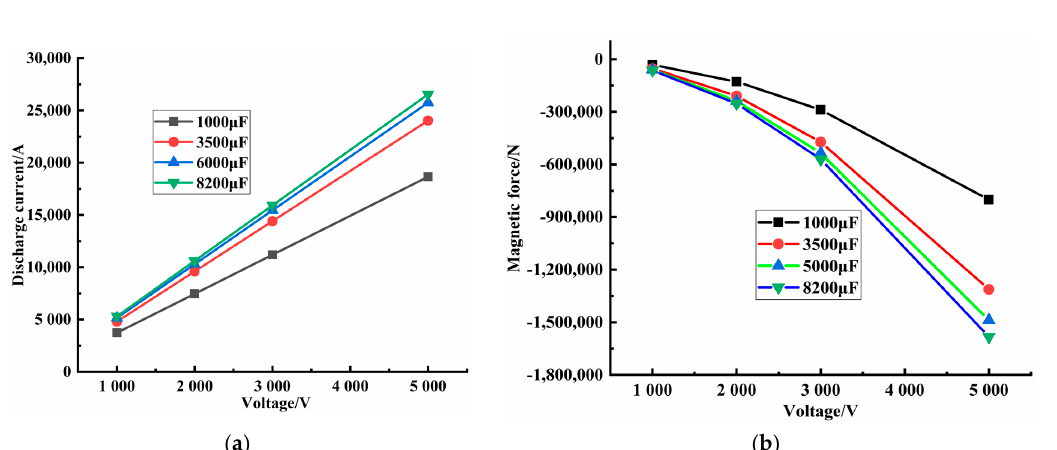
Figure 9. Magnetic force-voltage during the different capacitance. ( a ) Relationship between voltage and current; ( b ) Relationship between voltage and magnetic force.